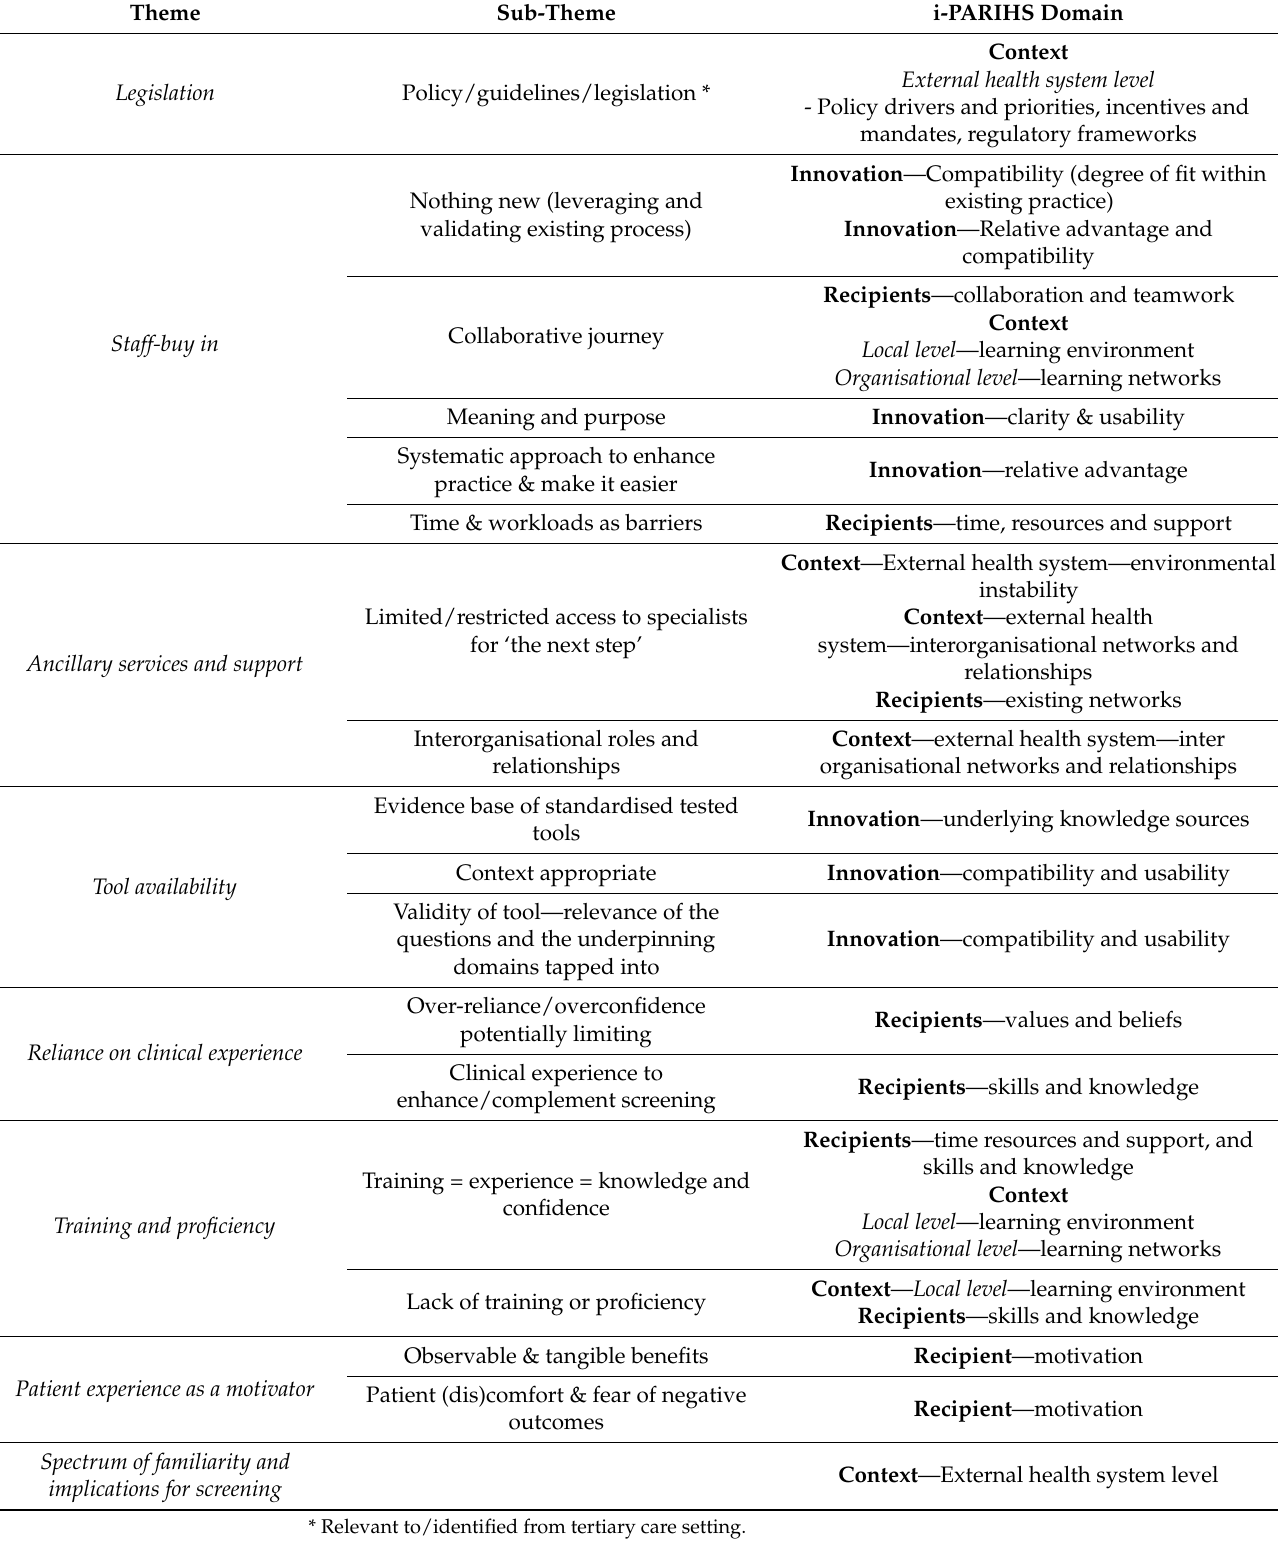
Table 3. Themes and sub-themes generated, and associated i-PARIHS